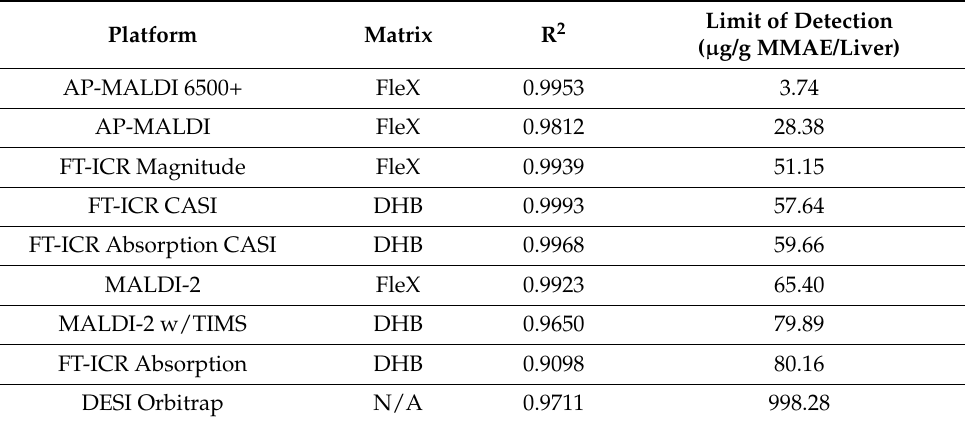
Table 2. Comparison of lowest limit of detection across the imaging platforms, adjusted to 20 µ m 2 pixels. While 3 matrices were used in the initial experiment, DHA did not provide the lowest LoD for MMAE. R 2 values of the linear regression are generally poorer than for felodipine, but all are above